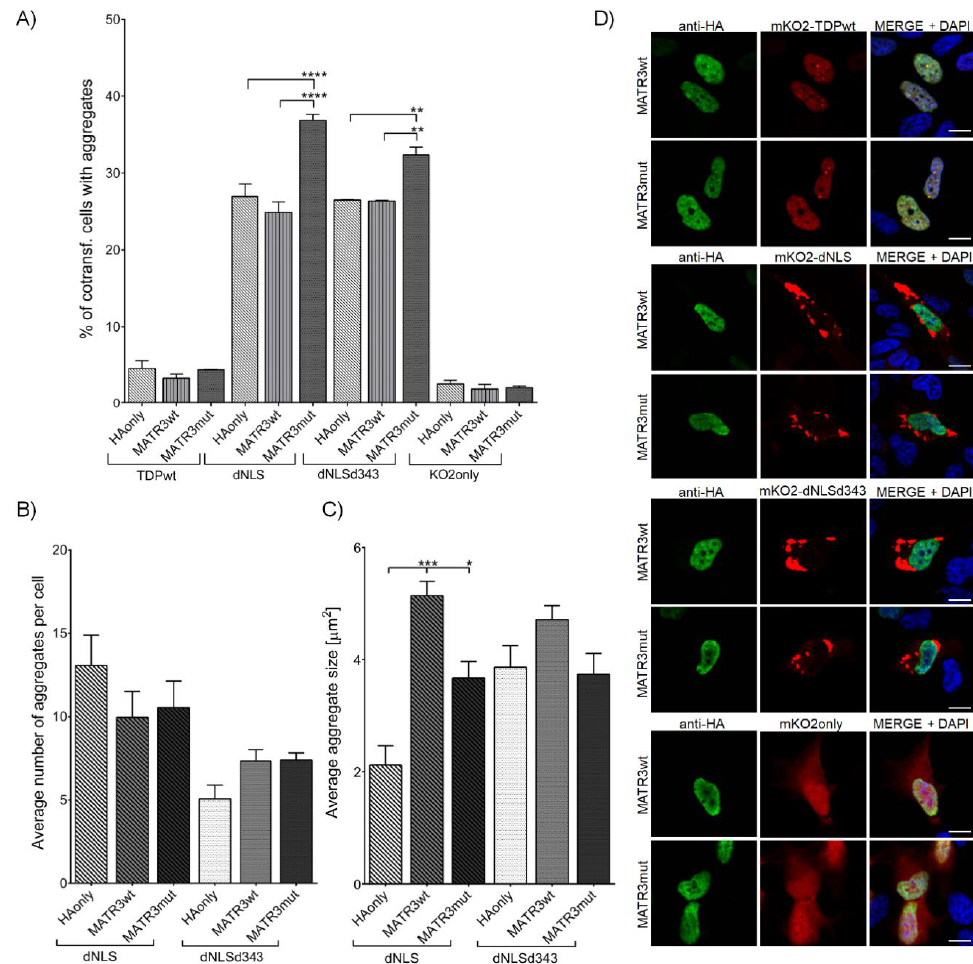
Figure 3. SH-SY5Y cells co-transfected with mKO2 constructs and wt or mut MATR3. ( A ) Quantification of co-transfected cells harboring aggregates. ( B ) Average number of aggregates in an individual cell. ( C ) Average aggregate size. ( D ) SH-SY5Y cells co-transfected with mKO2 constructs and wt or mut MATR3. Probed for HA-tag and counterstained with DAPI. Scale bars: 10 µm.